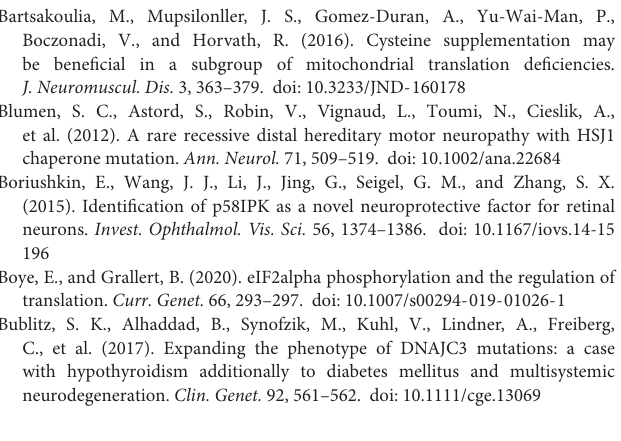
Supplementary Figure 1 | DNAJC3 expression in different tissues (brain, skin, and muscle) as depicted on GTEx Portal